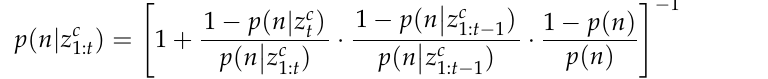
Figure 12. Memory management mechanism of RTAB-MAP.